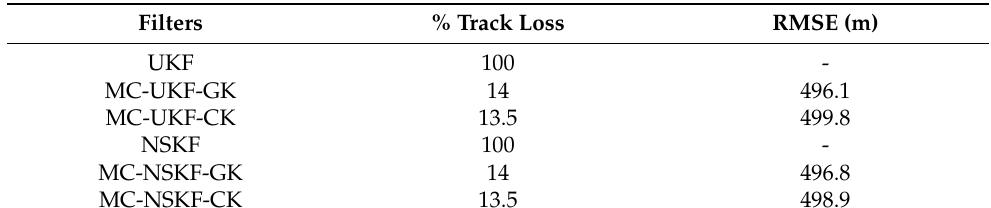
Table 4. 3D: RMSE in position and % Track Loss.